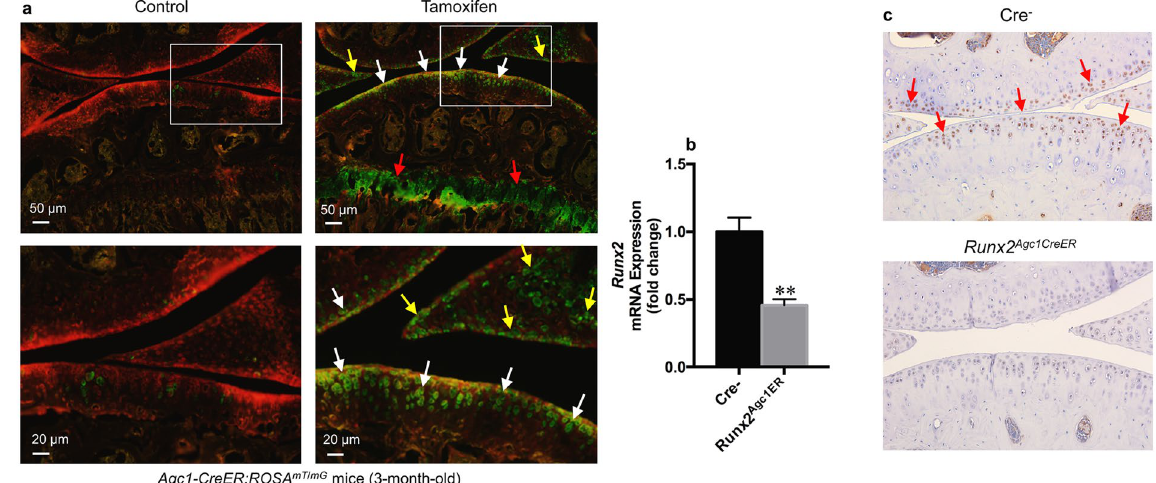
Figure 1. Directed Cre recombination in articular chondrocytes from Agc1-CreER mice. ( a ) Agc1-CreER mice target articular chondrocytes in adult mice. Agc1-CreER; ROSA mT/mG mice were generated by breeding Agc1-CreER transgenic mice with ROSA mT/mG reporter mice. Tamoxifen or vehicle control was administered into 2-month-old Agc1-CreER; ROSA mT/mG mice. Bone samples were harvested from 3-month-old mice after they were injected with tamoxifen at age of 2 months (1 mg/10 g body weight, i.p. injection, daily for 5 days). Histologic sections of Agc1-CreER; ROSA mT/mG mice with or without tamoxifen treatment were analyzed by fluorescence microscopy. The results showed that Agc1-CreER targeting GFP-positive cells (green color cells) are located in growth plate (red arrowheads), articular cartilage (white arrowheads) and meniscus (yellow arrowheads) in Agc1-CreER; ROSA mT/mG mice. ( b ) Significant decrease in Runx2 mRNA expression was observed in Runx2 Agc1CreER mice compared to their Cre-negative littermates. Total RNA was isolated from articular cartilage of 5-month-old Runx2 Agc1CreER mice and their Cre-negative littermates and real-time PCR assay was performed. All mice were administrated with tamoxifen at 2-months of age ( ** P < 0.01 versus Cre- negative mice, unpaired Student’s t -test; n = 3 mice per group). ( c ) Immunohistochemical (IHC) results showed that Runx2 protein levels were significantly decreased in articular cartilage of Runx2 conditional KO mice compared to Cre-negative mice (Red arrowheads show Runx2 positive cells, n = 3 mice per